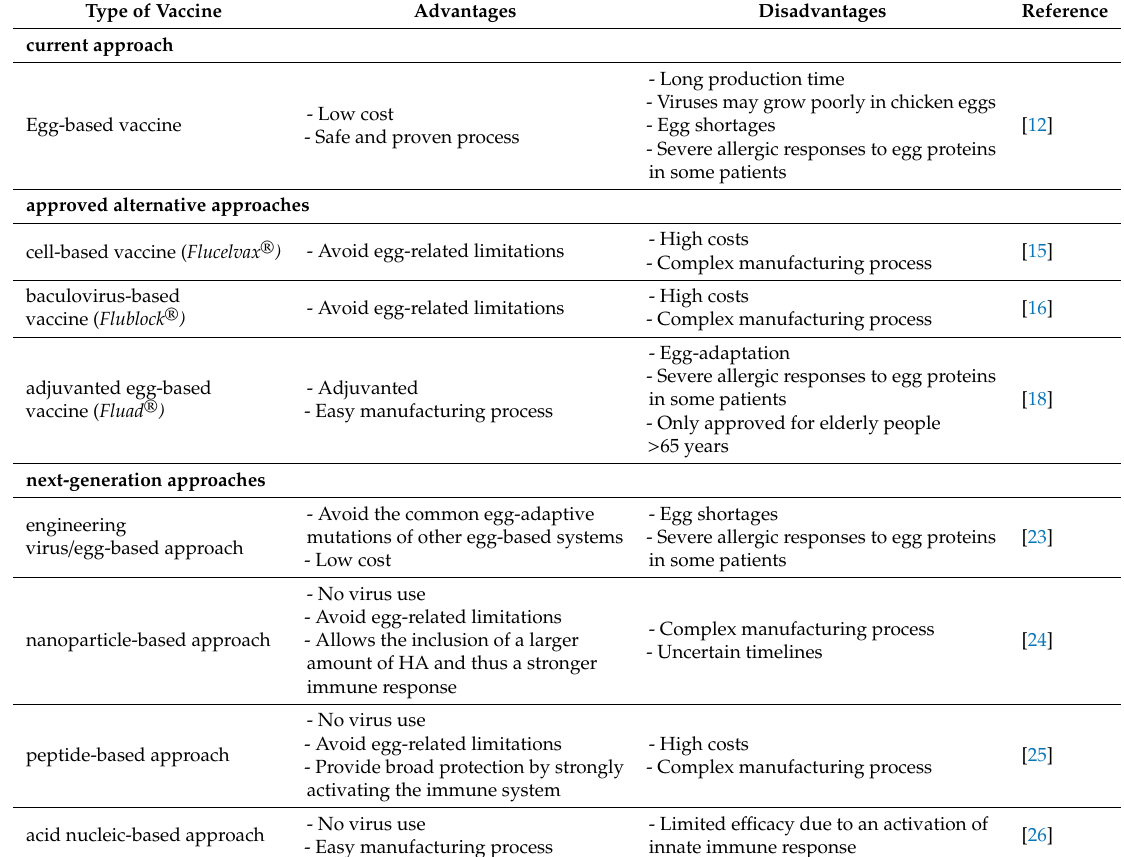
Table 1. Advantages and disadvantages of di ff erent influenza